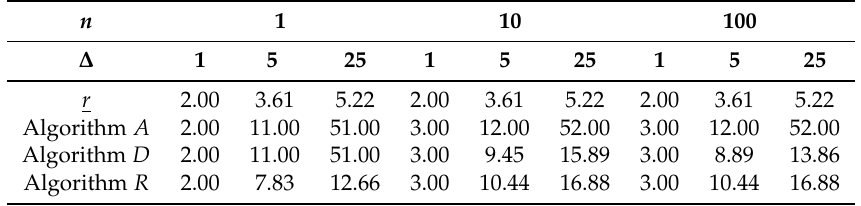
Table 2. Numerical values of lower bound on competitive ratios (CRs) from Theorems 2 and either CRs or upper bounds on CRs from Theorems 3–5. The formulae for calculating these values can be found in the respective theorem statements. Algorithm A represents any greedy